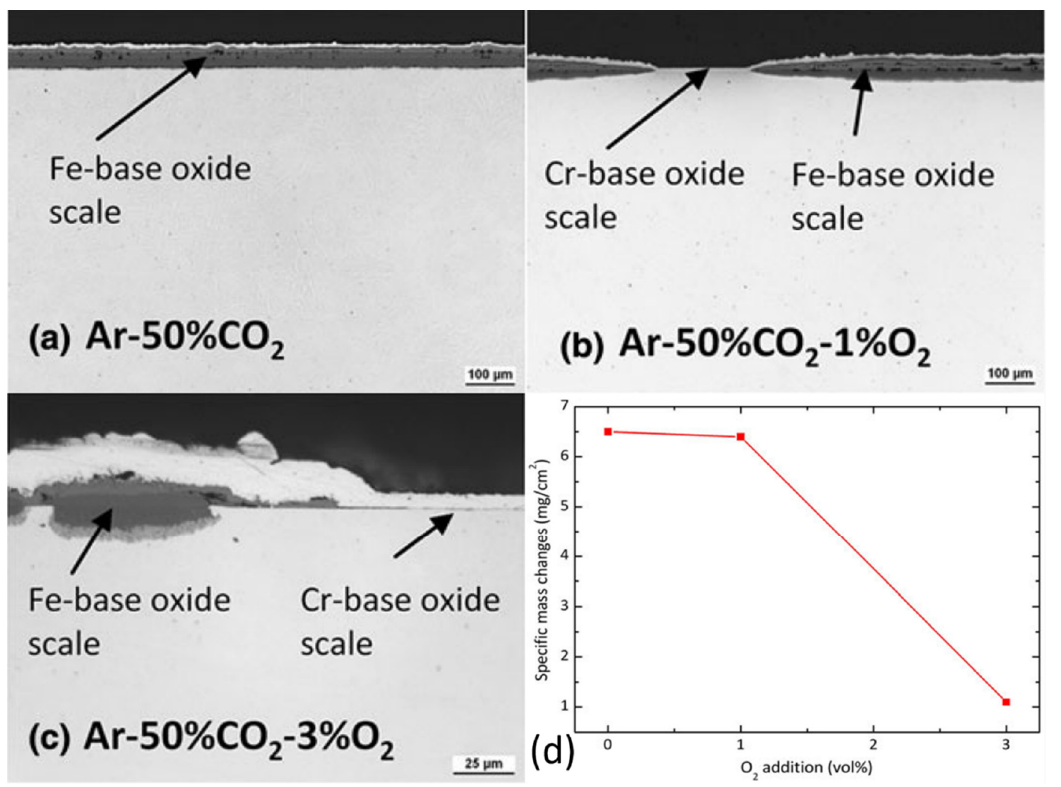
Figure 13. Cross-sections of P92 exposed at 550 °C in ( a ) Ar–50%CO 2 , ( b ) Ar–50%CO 2 –1%O 2 and ( c ) Ar–50%CO 2 –3%O 2 . ( d ) Effect of excess oxygen on the oxidation mass gain of P92 after 250 h in Ar– 50%CO 2 at 550 °C [21]. Reproduced with permission from Springer Nature.